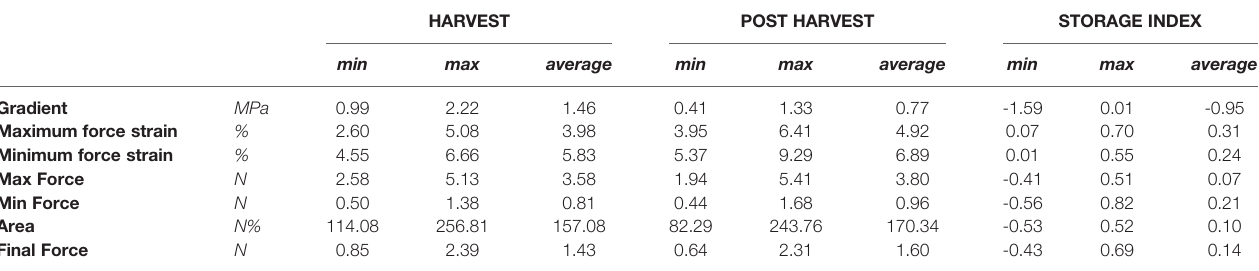
TABLE 2 | Texture parameters detected by a texture analyzer at harvest and after storage, over 46 Vaccinium spp. cultivars.